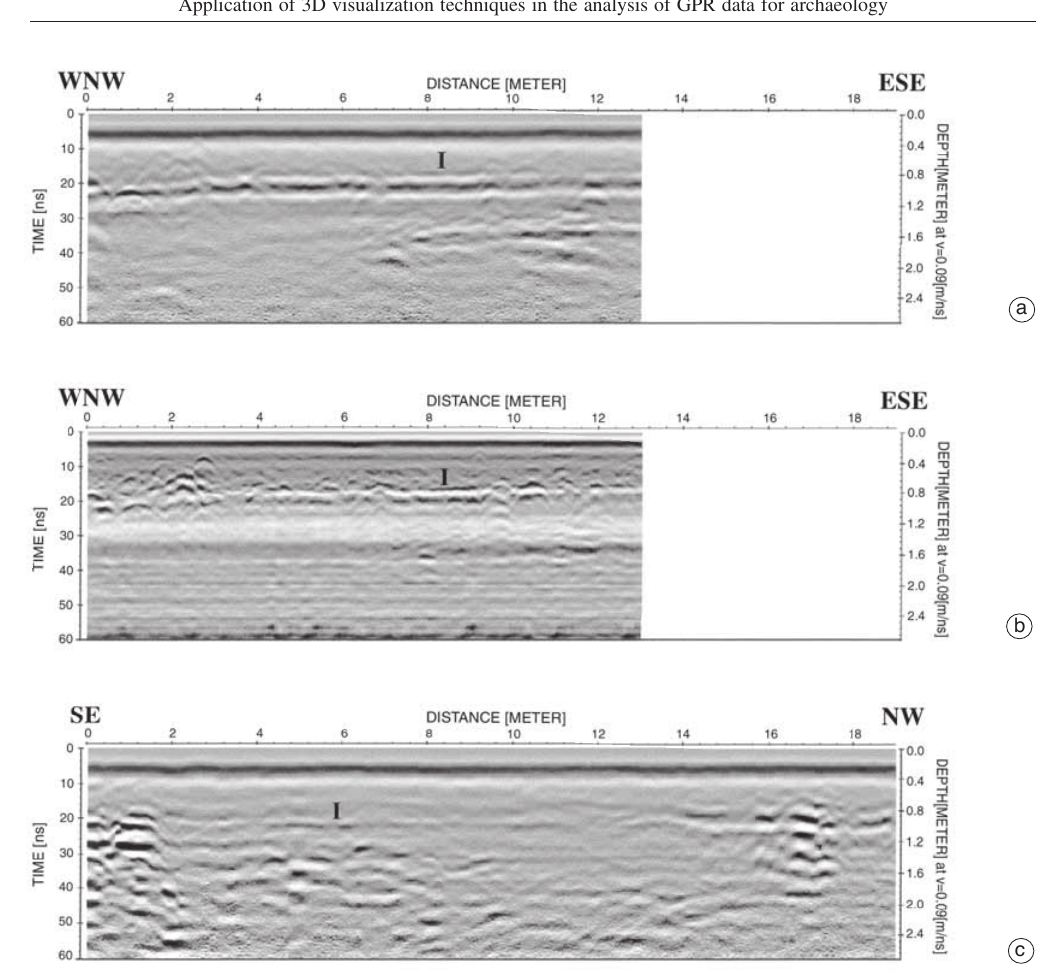
Fig. 4a-c. Examples of radar sections from profiles relative to the northern part of the site: Profile L4, 200 MHz (a) and 500 MHz (b); Profile L3, 200 MHz (c). I denotes the soil-bedrock